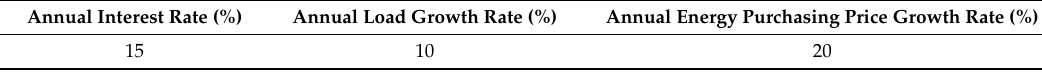
Table 3. Economic parameters.